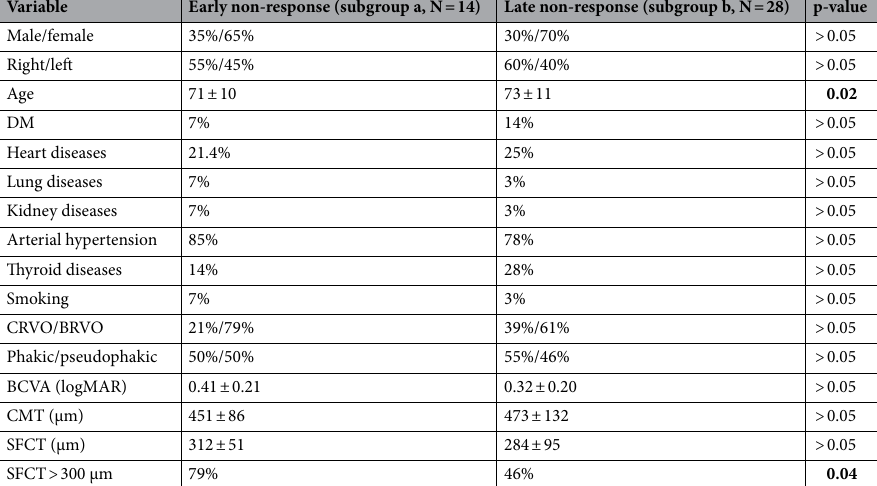
Table 2. The baseline characteristics of both subgroups. Significant values are in bold. Subgroup a (early non- response group, n = 14): eyes that showed non-response to intravitreal bevacizumab at the end of upload phase. Group 2 (late non-response group, n = 28): eyes that showed late non-response to intravitreal bevacizumab during follow-up after an initial response. SD standard deviation, DM diabetes mellitus, BCVA best-corrected visual acuity, CMT central macular thickness, SFCT subfoveal choroidal thickness, CRVO central retinal vein occlusion, BRVO branch retinal vein occlusion.